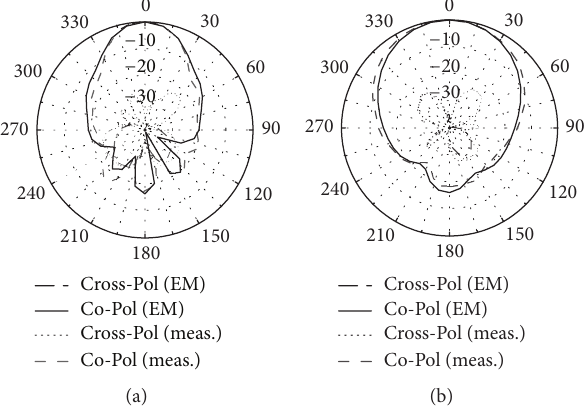
Figure 12: Normalized radiation patterns at 2.4 GHz for port 2 excited: (a) 𝜑 = 90 ∘ ; (b) 𝜑 = 0 ∘